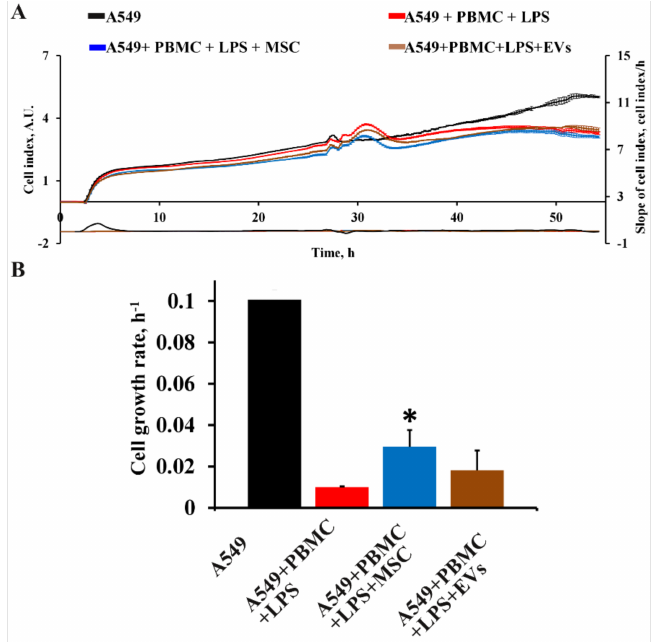
Figure 9. The effect of MSC and EVs on proliferation of A549 cells for 24 h in a model system. ( A ) The real-time curve of cell index for A549 cells and ( B ) the cell growth rate measured using RTCA iCELLigence for 35–50 h. The data are presented as a mean ± SEM, n = 3. * p < 0.05 vs.